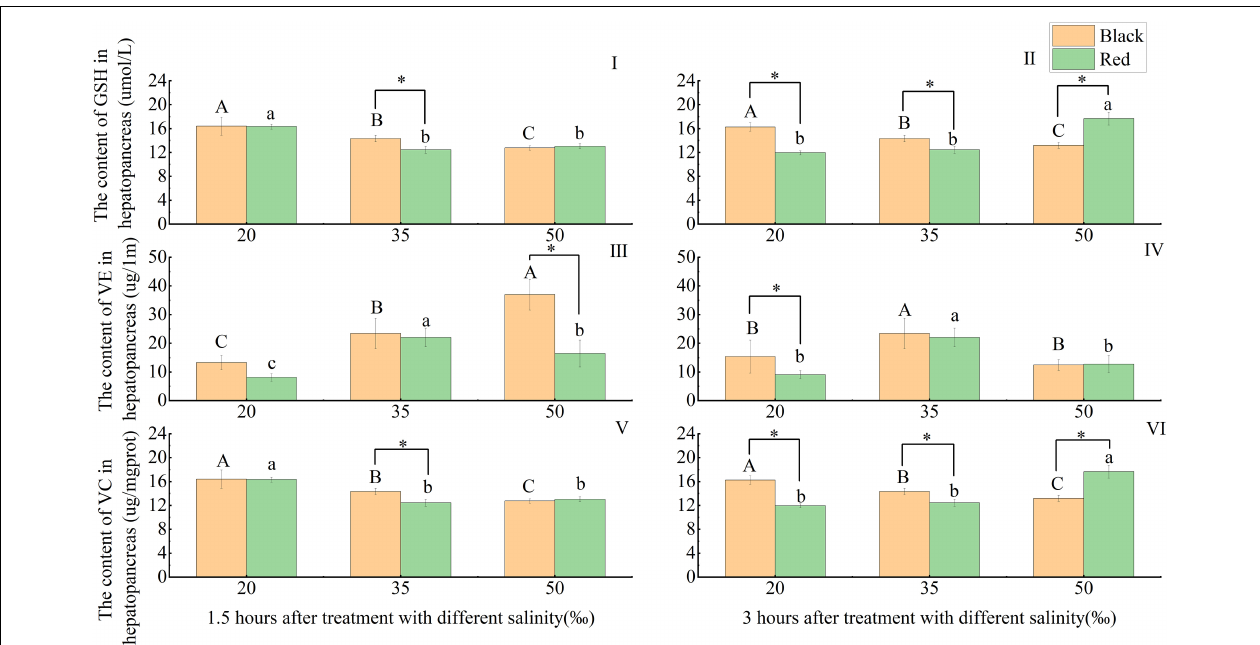
FIGURE 5 | Effects of acute salinity stress on the contents of glutathione (GSH), vitamin E (VE), and vitamin C (VC) in the hepatopancreas of black and red P. fucata ( I: 1.5 h, GSH content. II: 3 h, GSH content. III: 1.5 h, VE content. IV: 3 h, VE content. V: 1.5 h, VC content. VI: 3 h, VC content). The asterisk sign “ ∗ ” indicates that there are significant differences between the different shell colors at the same salinity ( p <